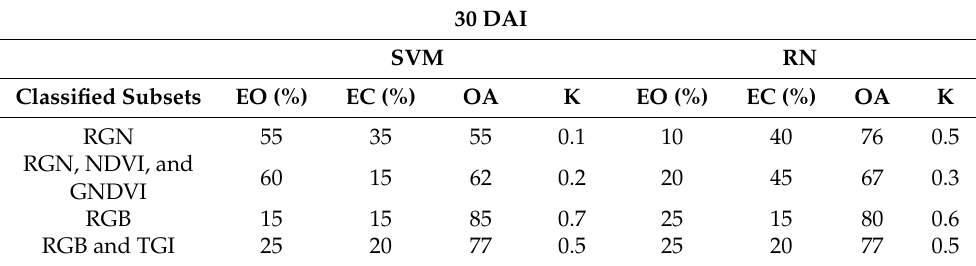
Table 4. Supervised classification of coffee seedlings inoculated and non-inoculated by H. vastatrix , at 30 days after inoculation (DAI), and omission errors (EO), commission error (EC), global accuracy (AG), and Kappa index